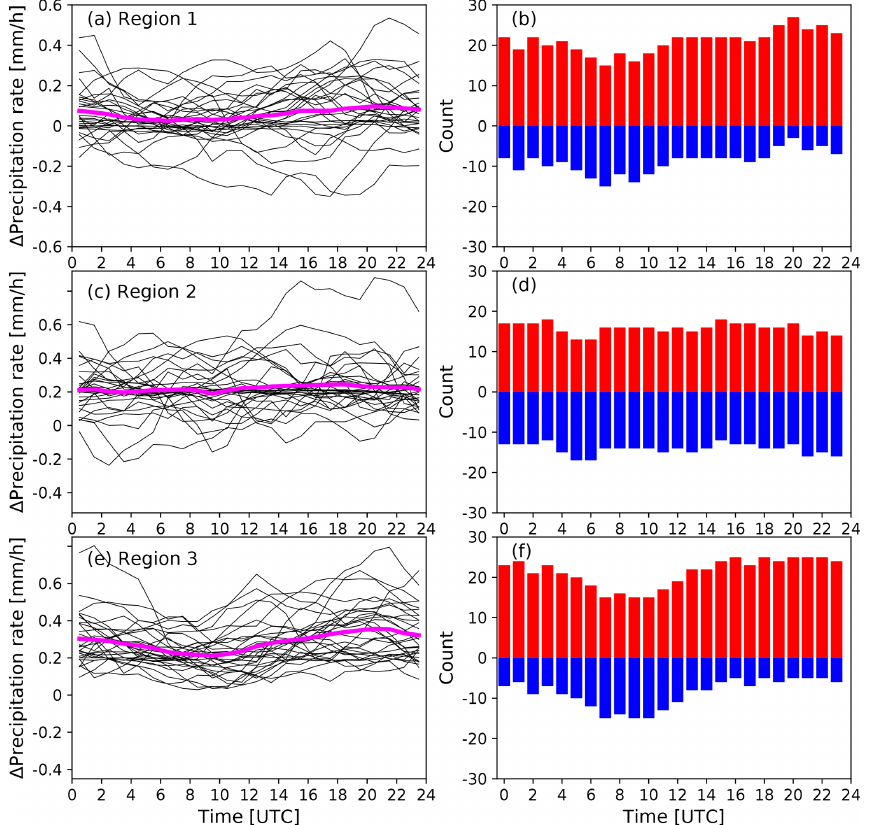
Figure 10. (a, c, e) FIRE − NOFIRE differences in hourly precipitation rate (mmh − 1 ) each day in September (black) and their monthly average (magenta). (b, d, f) Raw counts of increased ( + 1, red) or decreased ( − 1, blue) hourly rainfall rates (FIRE − NOFIRE). All are averages over (a, b) Region 1, (c, d) Region 2, and (e, f) Region